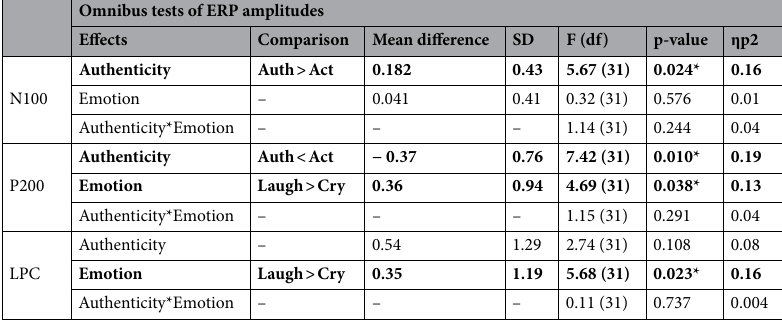
Table 2. Summary of the main effects and interactions of authenticity and emotion category on N100, P200 and LPC amplitudes. Statistically significant effects (p < 0.05) are signalled with a bold font and an asterisk.